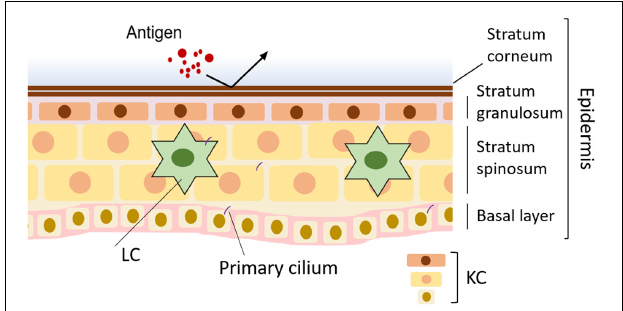
FIGURE 1 | Normal skin and disruption of primary cilia in skin disease. In normal skin, the barrier formed by keratinocytes (KCs) blocks infection. Langerhans cells (LCs) in the epidermis contribute to skin homeostasis by working as antigen-presenting cells.